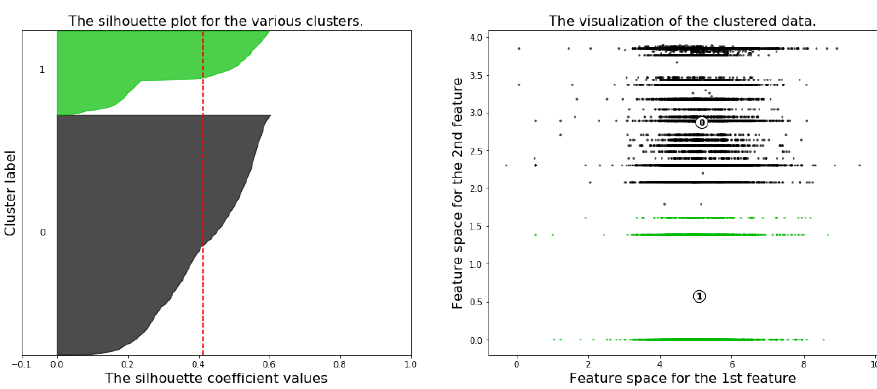
Figure 13. Silhouette analysis where the number of clusters is 2.